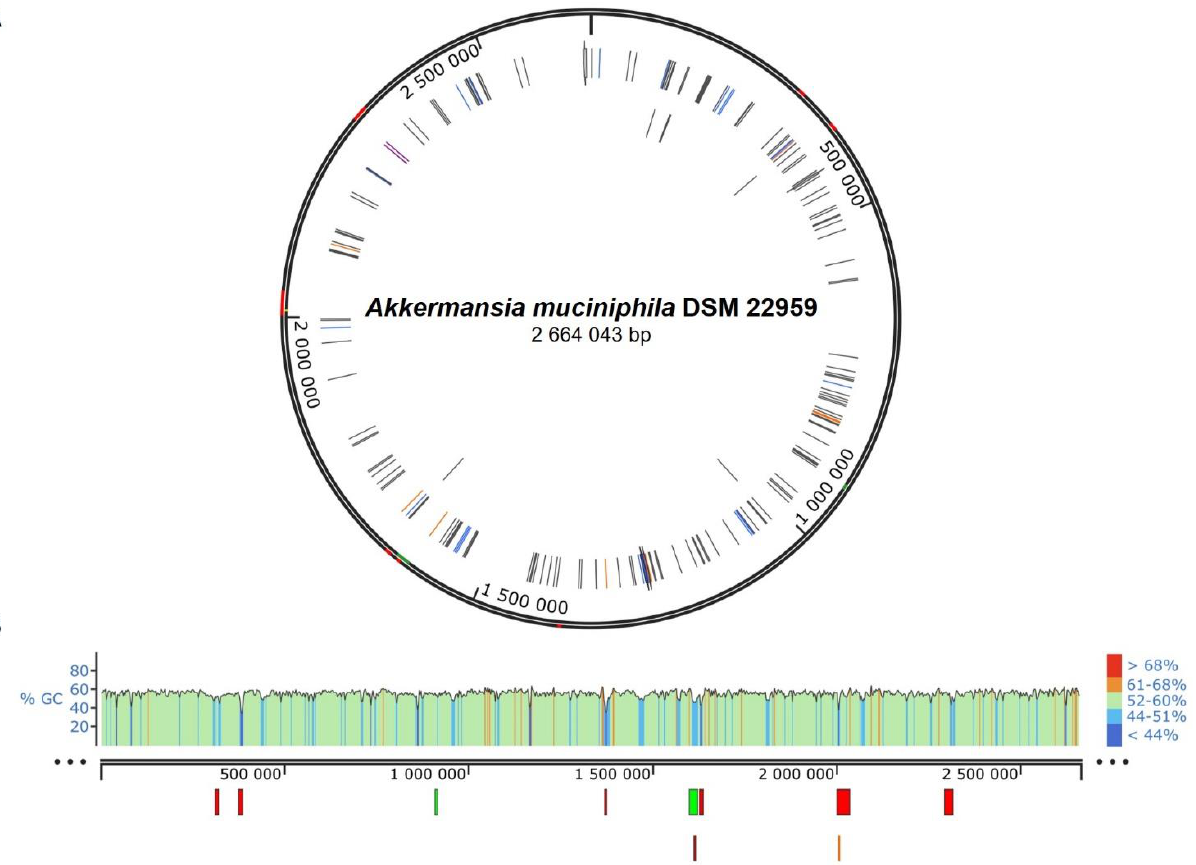
Figure 1. Akkermansia muciniphila DSM 22959 genome map. ( A ) represents the whole chromosome, with MGE (in orange), GI (in red) and Prophage-like region (in green), highlighted in the external circles; possible ARG, identified by CARD are represented inside the chromosome circle: in blue, ARG confirmed with PATRIC and CARD; in grey, ARG identified only by CARD; in orange, ARG identified only by PATRIC and in purple ARG encoded within a GI. ( B ) GI (red bars), MGE (orange bar) and prophage-like region (green bar) representation and GC content across the chromosome, with colour coded scheme, to ease the correlation. Images produced in SnapGene